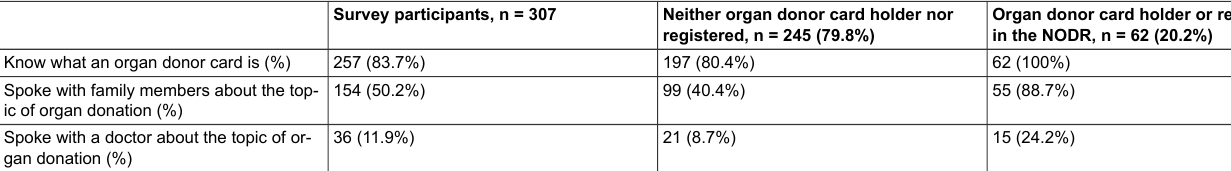
Table 2: Knowledge and information about the organ donation.